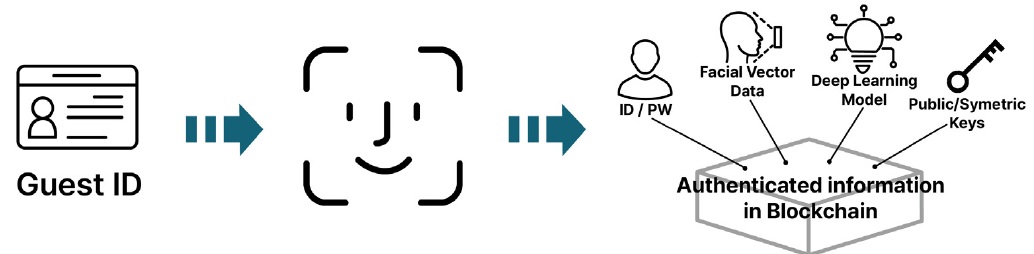
Figure 7. Authentication information storage.